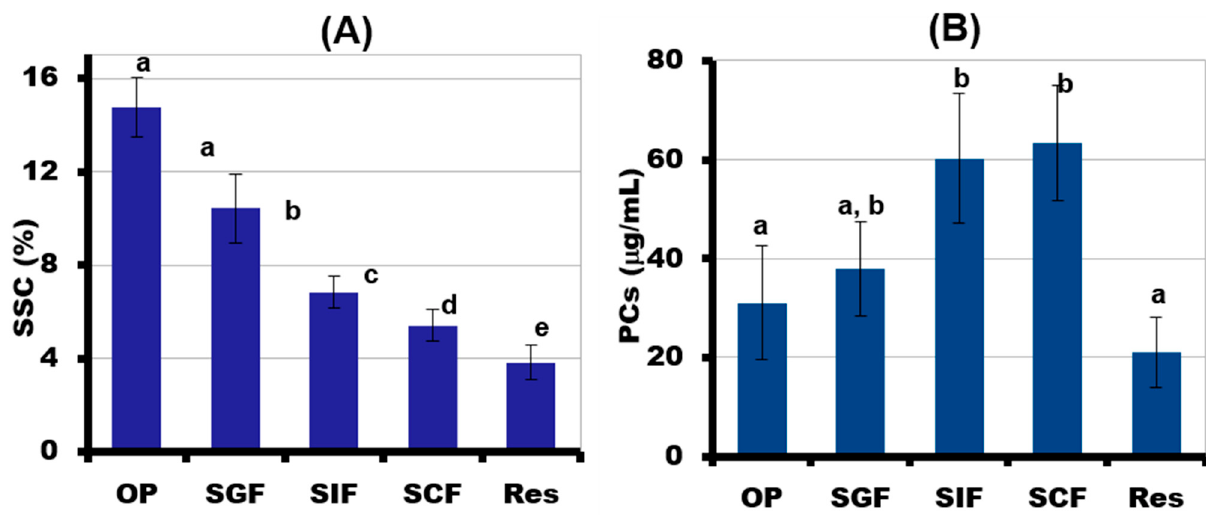
Figure 9. The amount of soluble solids content (SSC) ( A ) and total phenolic compounds (PCs) ( B ) released from LA16-33 gel during successive oral in vivo (OP) and gastrointestinal in vitro phases of digestion. SGF, SIF, and SCF—simulated gastric, intestinal, and colonic fluids, respectively. The data are presented as the mean ± SD. Different lowercase letters indicate significant differences among means for the different phases of digestion ( n = 6, p < 0.05).